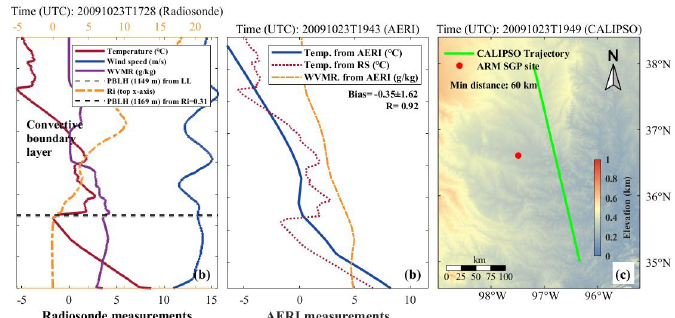
Figure 7. ASR was measured by CALIOP from 19:49:29 to 19:50:19 on 23 October 2009 (UTC, daytime) ; PBLHs were determined with ( a ) MSD, ( b ) MGD, ( c ) WCT, ( d ) IPF, and ( e ) RANSAF methods.